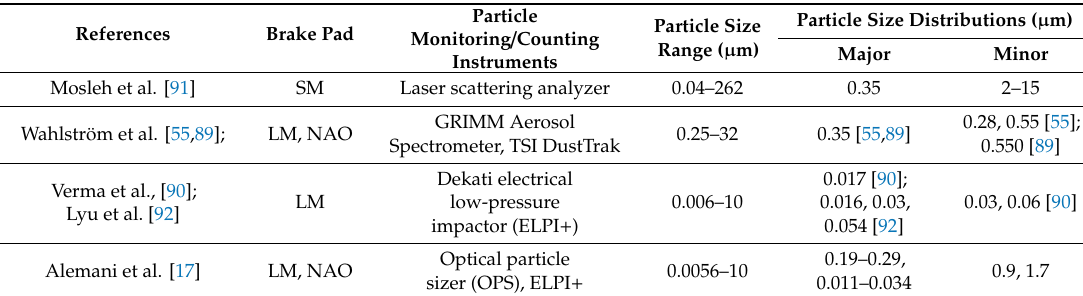
Table 4. Overview of selected pin-on-disc (PoD)